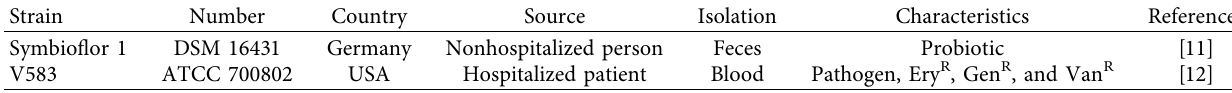
Table 1: Enterococcus faecalis strains used in this